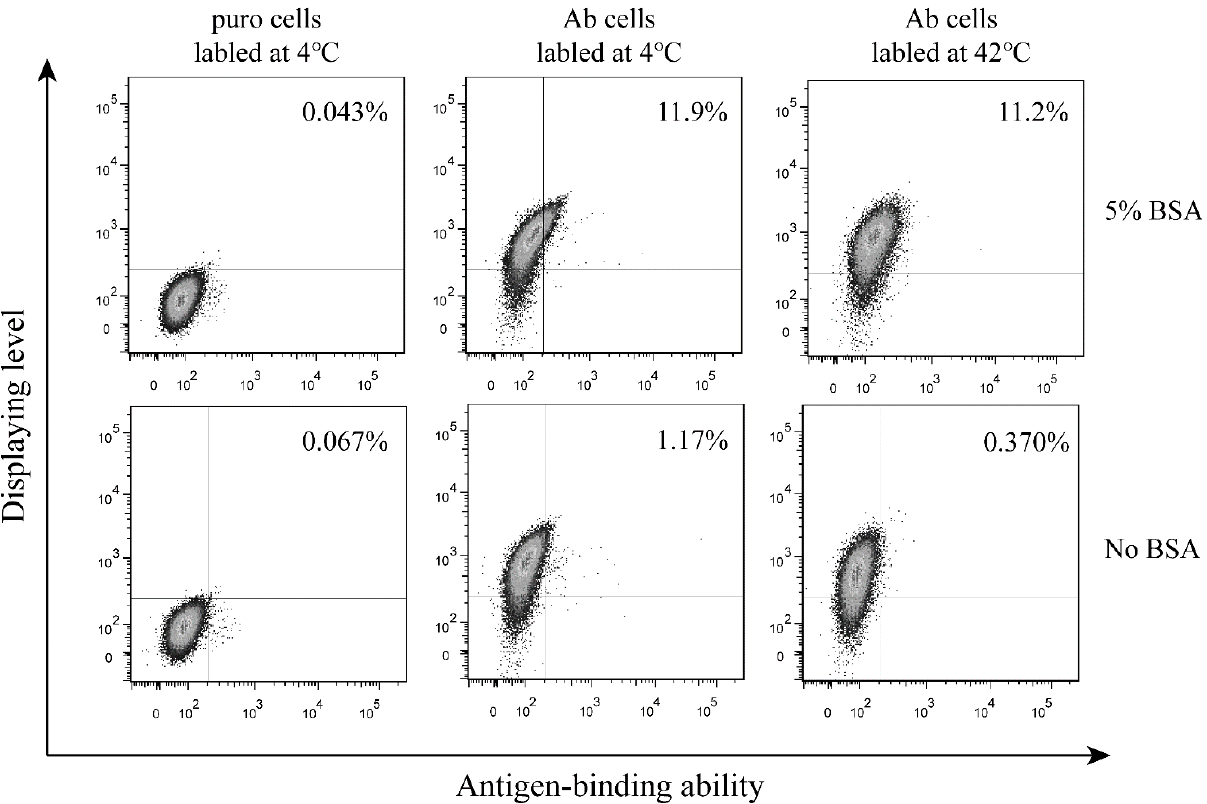
Figure 4. Effects of different labeling conditions on antibody display and antigen-binding detected with flow cytometry. TR cells displaying anti-TNF α antibody (Ab) were labeled for detecting antibody display and for monitoring antibody affinity at 4 °C and 42 °C for 1/2 h with and without BSA (5%), then subjected to flow cytometric analysis.